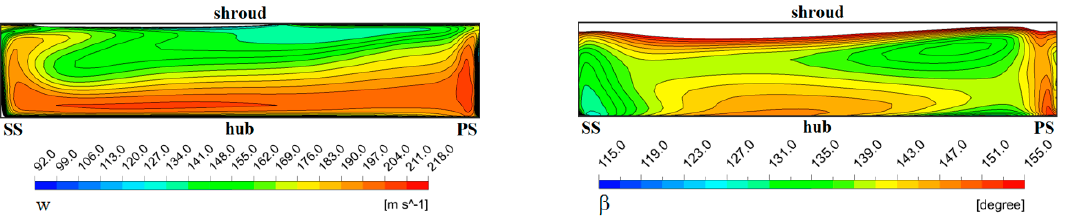
Figure 12. Relative velocity and angle at impeller exit in the relative frame of reference, point P1.